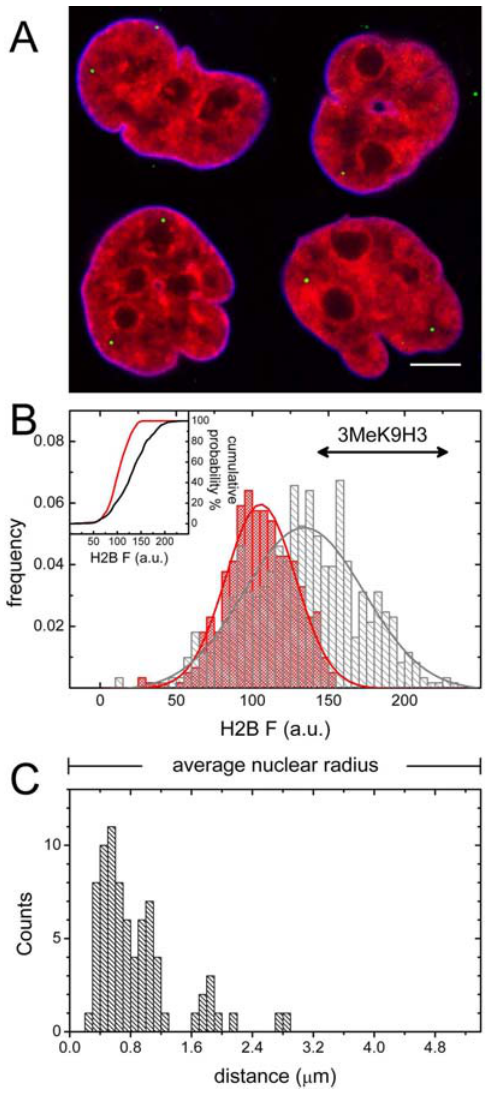
Figure 7. HIV-IN-ECFP virions preferentially localize in the periphery of the nucleus and outside heterochromatin regions. (A) Confocal images of HIV-IN-ECFP virions (green) in nuclei of HeLa cells expressing H2B-EYFP (red) and immunostained with antibody against lamin A/C (blue). Bar, 5 m m. (B) H2B-EYFP fluorescence intensity distribution frequency for PIC ROIs (defined by the HIV-IN-ECFP virions, red bars) and for Random ROIs (selected randomly in the same planes, grey bars) (n=103). Solid lines are obtained by Gaussian fitting. The 3MeK9H3 labeled arrow represents the width at half-height of the H2B- EYFP fluorescence intensity distribution derived by cross analyzing with this heterochromatin marker (see Experimental Procedures). In the inset the distribution cumulative probabilities are plotted for PIC ROIs (red) and Random ROIs (grey) ( P , 0.001, Kolmogorov–Smirnov test). (C) Distribution of intranuclear PICs distances from the lamin A/C